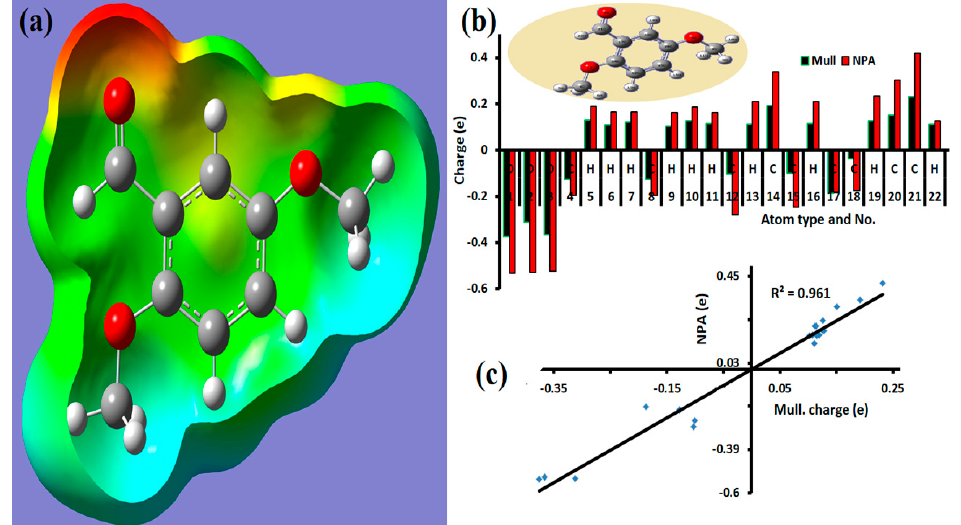
Figure 7. ( a ) B3LYP/6-311G(d,p) molecular electrostatic potential (MEP) map of exo -2,5- dimethoxybenzaldehyde. ( b ) Mulliken (Mull) and natural population analysis (NPA) atomic charges and ( c ) their graphical correlation. R 2 : correlation.